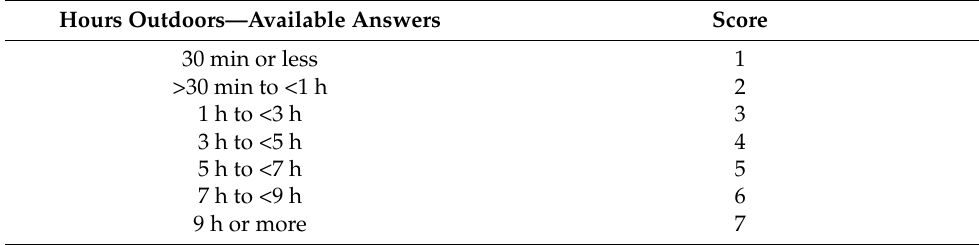
Table 2. Scoring system for lifestyle questionnaire responses of